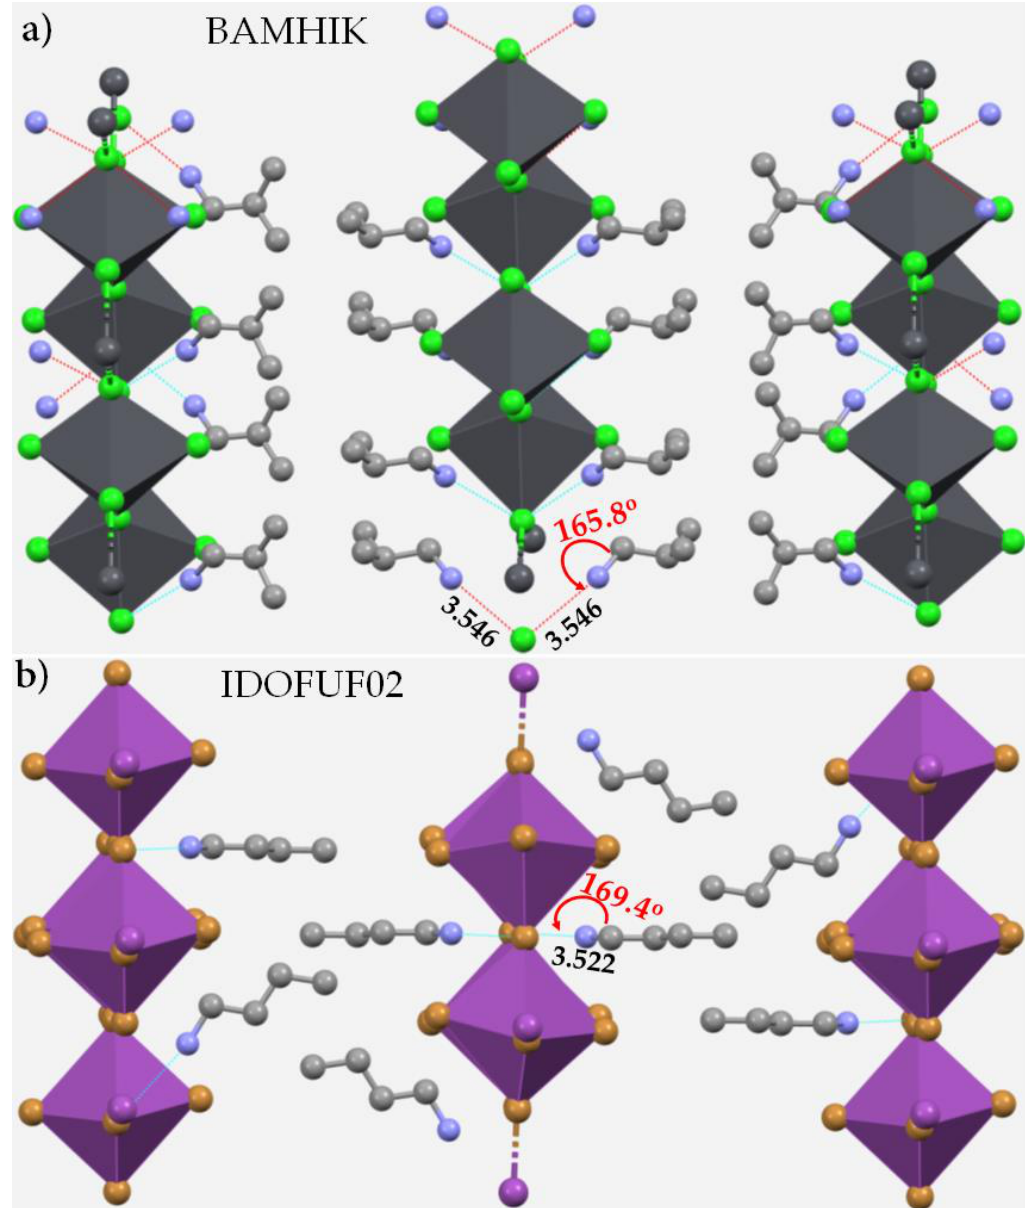
Figure 19. Polyhedral and ball-and-stick models of ( a ) [(CH 3 ) 2 CHCH 2 NH 3 ] 2 PbCl 4 and ( b )